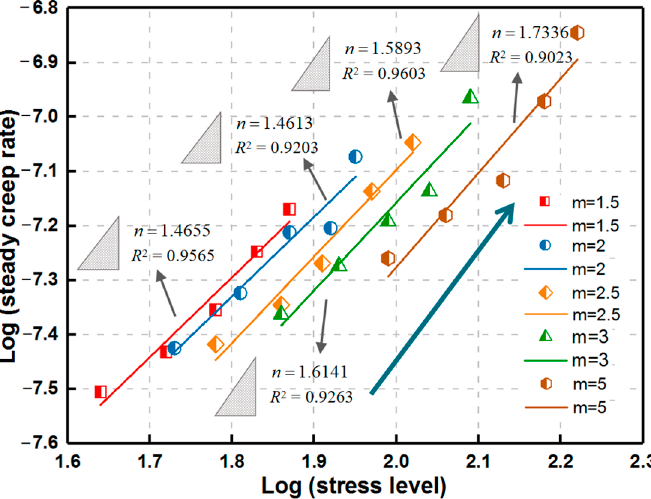
Figure 10. Relationship between stress level and steady creep rate for various homogeneity indexes during uniaxial creep loading.